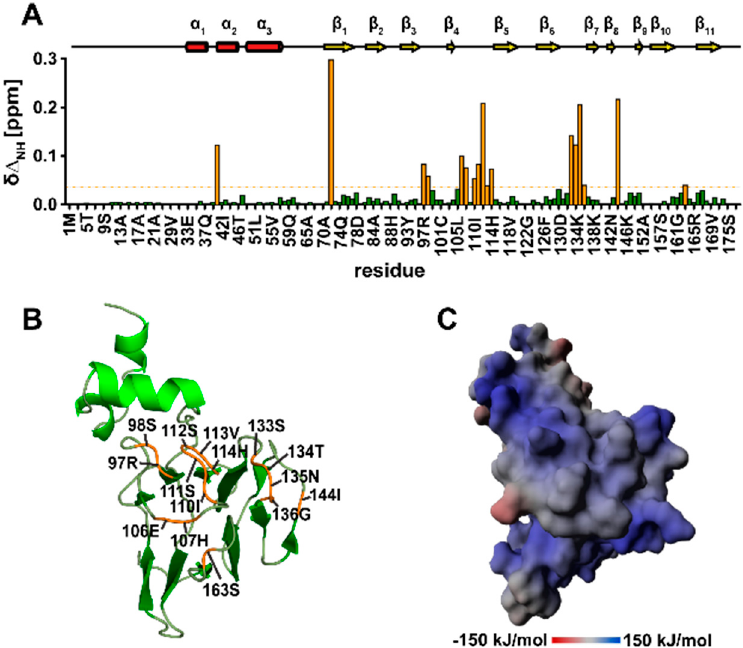
Figure 8. The phosphorylated peptide Suc-Ala-pThr-Pro-Ala-NH 2 is recognized by conserved phosphate binding loops of Tb Par42-FHA. ( A ) (top) Secondary structure elements of NterFHA. (bottom) Diagram showing NH chemical shift changes ( ∆ δ NH ) versus the amino acid sequence of Tb Par42_NterFHA 1–177 domain after addition of 13 mM peptide. Chemical shift perturbations observed for His41 and His72 may reflect tiny changes in pKs values, rather than indicating strong effects upon peptide addition [35]. Residues with a chemical shift larger than 0.04 ppm (orange dash line) are colored orange. ( B ) Residues of Tb Par42-FHA 33–177 showing chemical shift changes larger than 0.04 ppm in the presence of phosphorylated peptide are indicated and are orange colored. ( C ) Electrostatic surface of the NterFHA 33–177 generated with YASARA using the Particle Mesh Ewald method. The intensity of the electrostatic potential is gradually colored from dark red (negative) over grey (neutral) to dark blue (positive), representing energy levels from − 150 to +150 kJ/mol. The orientation of the structure is as in ( B ).